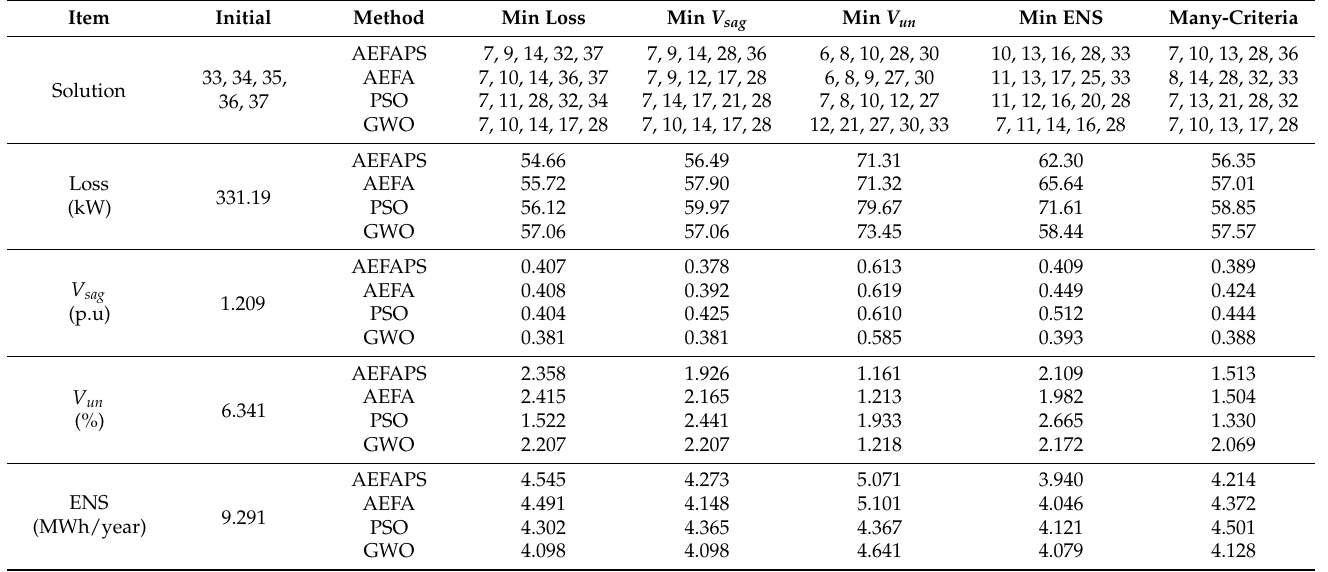
Table 5. The results of single-criterion and many-criteria reconfiguration of an unbalanced 33-bus network (62.5% of network nominal load).